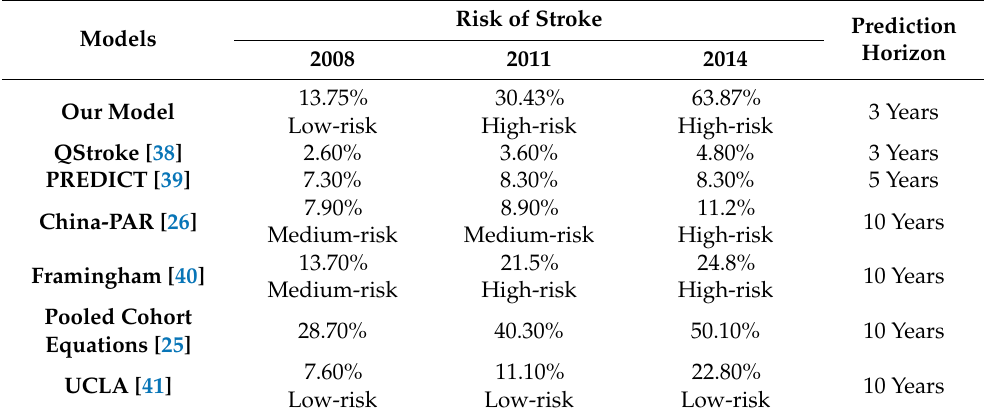
Table 4. Stroke risk comparison information, applying seven models to the case of Subject 1. The stroke risk levels are also shown when